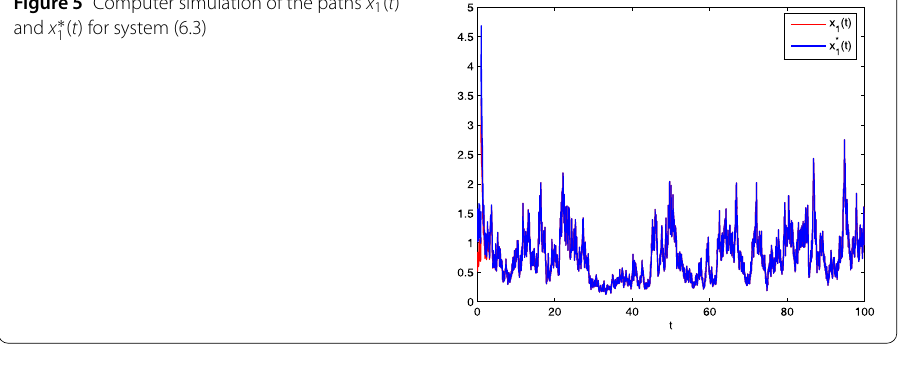
Figure 5 Computer simulation of the paths x 1 ( t ) and x ∗